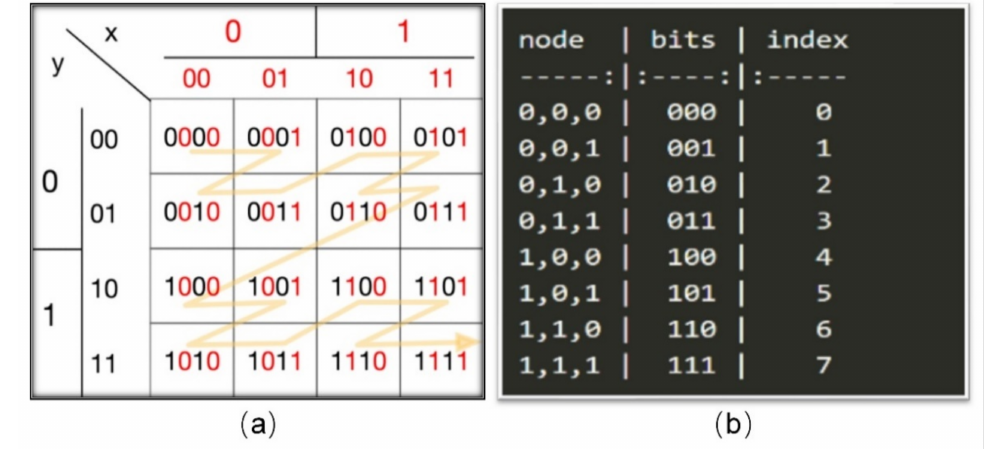
Figure 4. The work principle of Morton codes. ( a ) Morton code and traversal ordering for a 2D grid. ( b ) Schematic diagram of Morton code encoding and